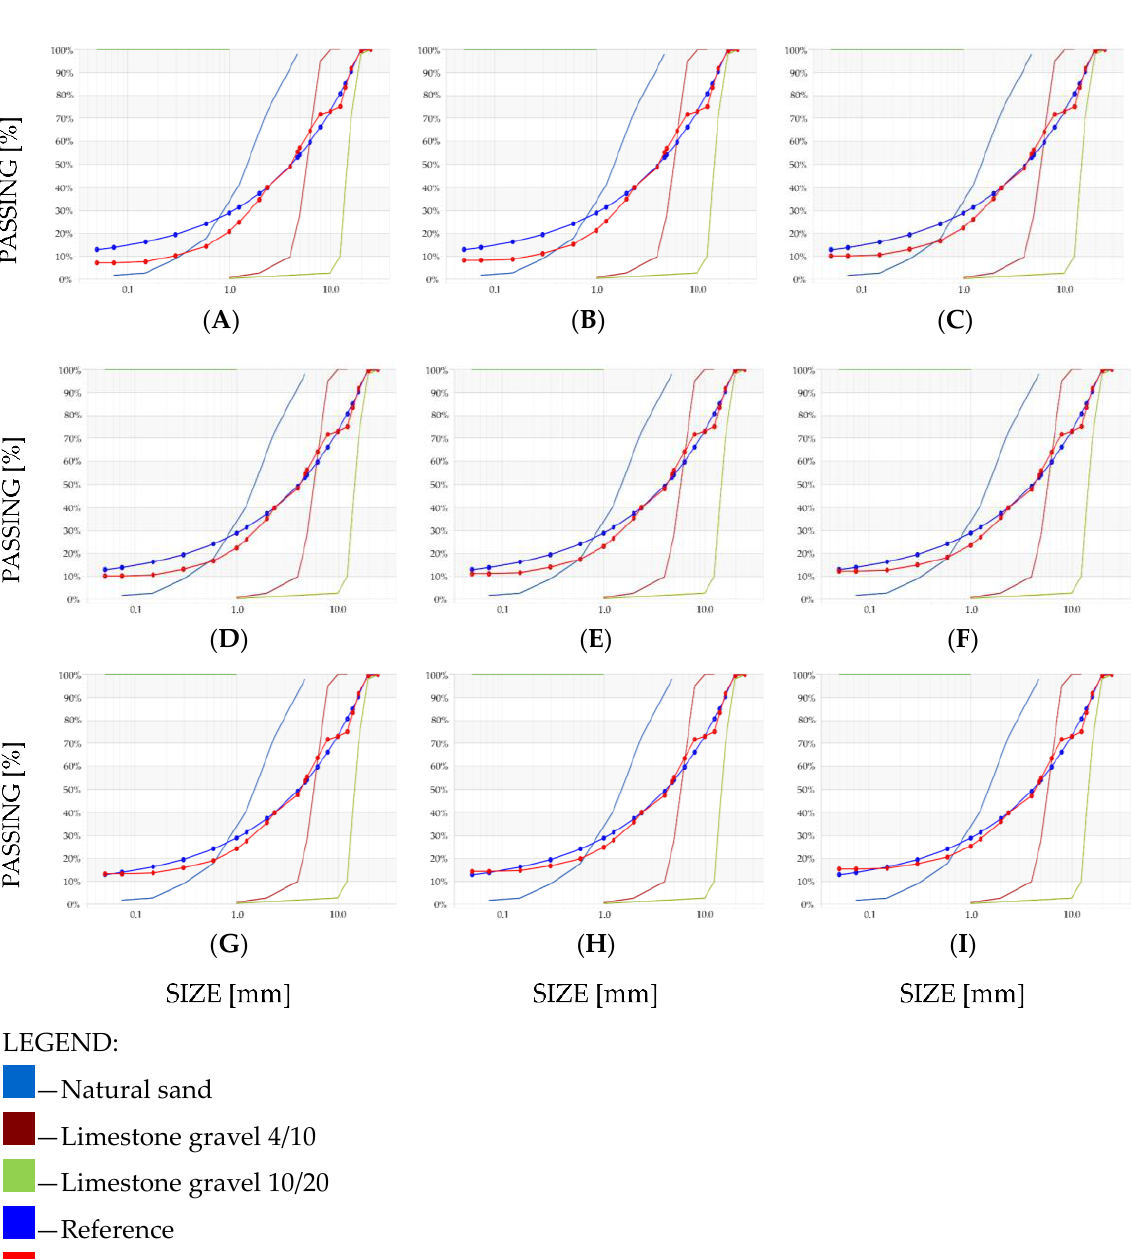
Figure A2. Gradings and fitting curves for Recipe #1—standard mix with plasticizer (lignosulfonate) and superplasticizer (polycarboxylate ether) designed according to the Fuller Method: ( A ) 10 MPa; ( B ) 15 MPa; ( C ) 20 MPa; ( D ) 25 MPa; ( E ) 30